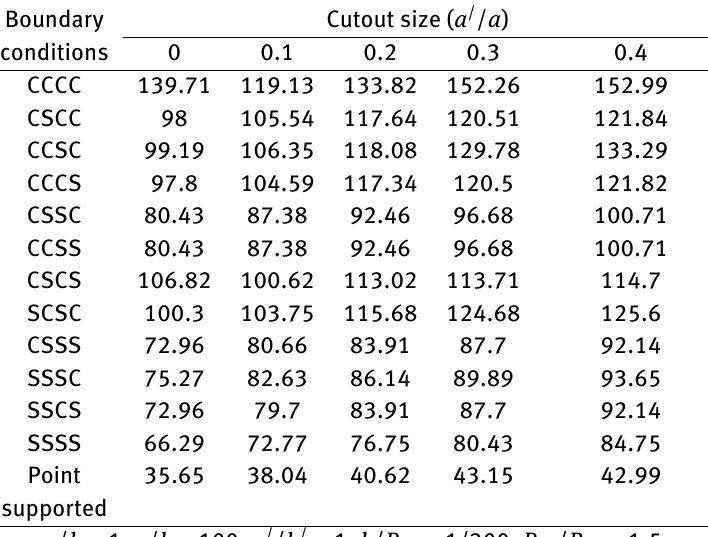
Table 3: Non-dimensional Fundamental Frequencies ( ω ) for laminated composite (0/90/0/90) stiffened elliptic parabolic shell for different sizes of the central square cutout and different boundary